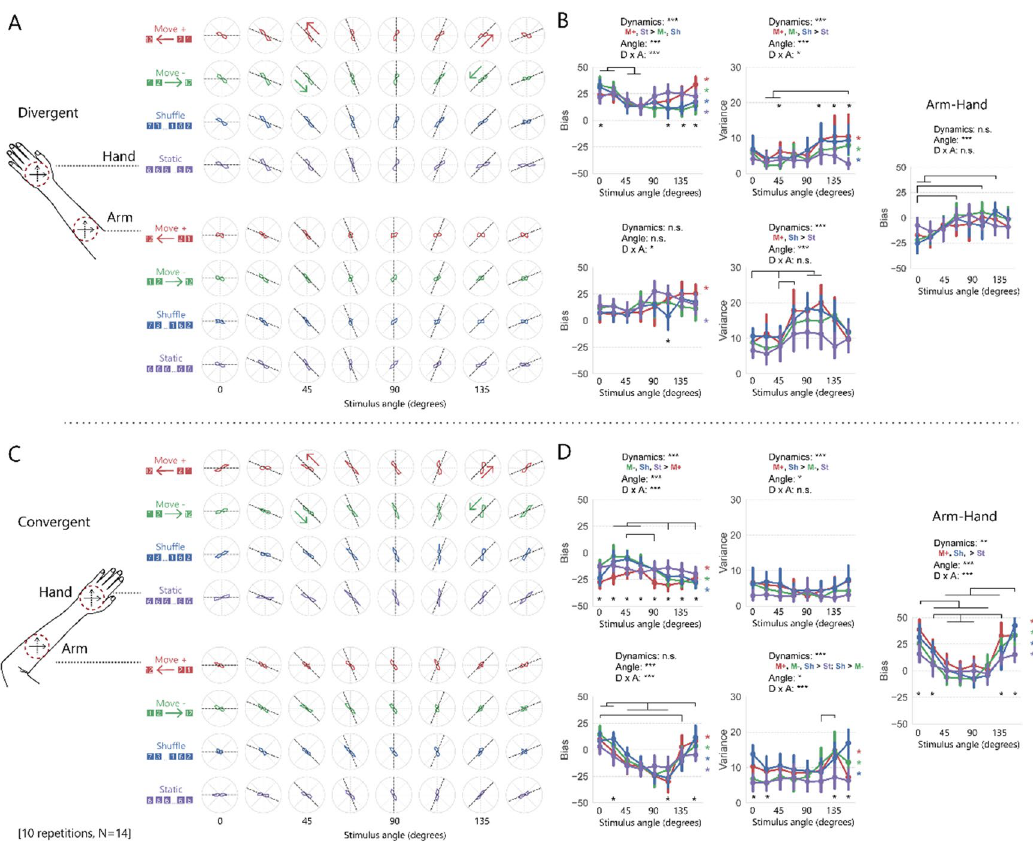
Figure 4. Results of Experiment 3. (A) The average rate of the stimulus orientation reported by the participants under divergent posture. The schematic illustration of axes drawn on the hand or arm shows the coordinates (fixed in space) that the participants were asked to use to report perceived shape. (B) The bias and variance of the reported orientation under divergent posture. The rightmost panel shows the angle bias reported on the arm minus the angle bias reported on the hand. The error bars represent 95% CIs. (C) The average rate of the stimulus orientation reported by the participants under convergent posture. (D) The bias and variance of the reported orientation under convergent posture. The rightmost panel shows the angle bias reported on the arm minus the angle bias reported on the hand.